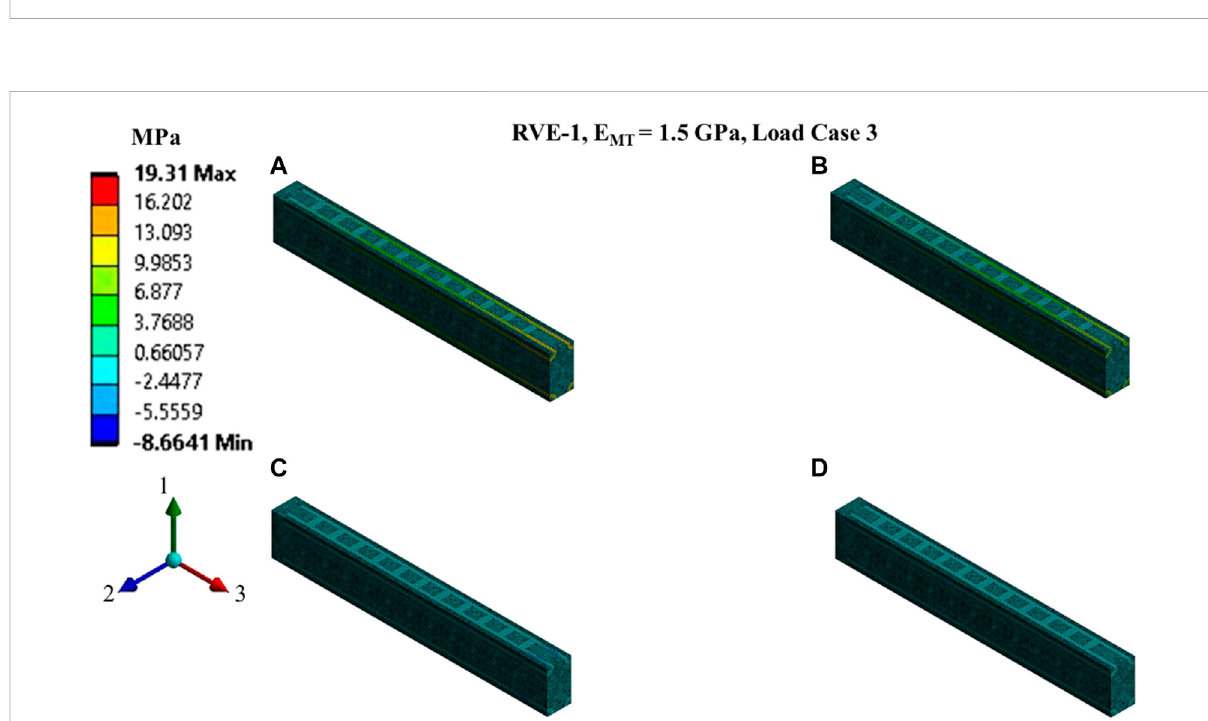
FIGURE 9 Contour plot of the element normal stress in direction 3 ( [ σ 3 ( t )] ρ from Eq. 16). C 13 ( t ) , C 23 ( t ) and C 33 ( t ) estimation for the RVE-1 with E MT (cid:2) 1 . 5 GPa by imposing the load case 3. (A) t 1 (cid:2) 3 ms , δ 3 ( t 1 ) (cid:2) 3 nm (B) t 2 (cid:2) 12 ms , δ 3 ( t 2 ) (cid:2) 3 nm (C) t 3 (cid:2) 15 ms , δ 3 ( t 3 ) (cid:2) 0 nm (D) t 4 (cid:2) 40 ms , δ 3 ( t 4 ) (cid:2) 0 nm